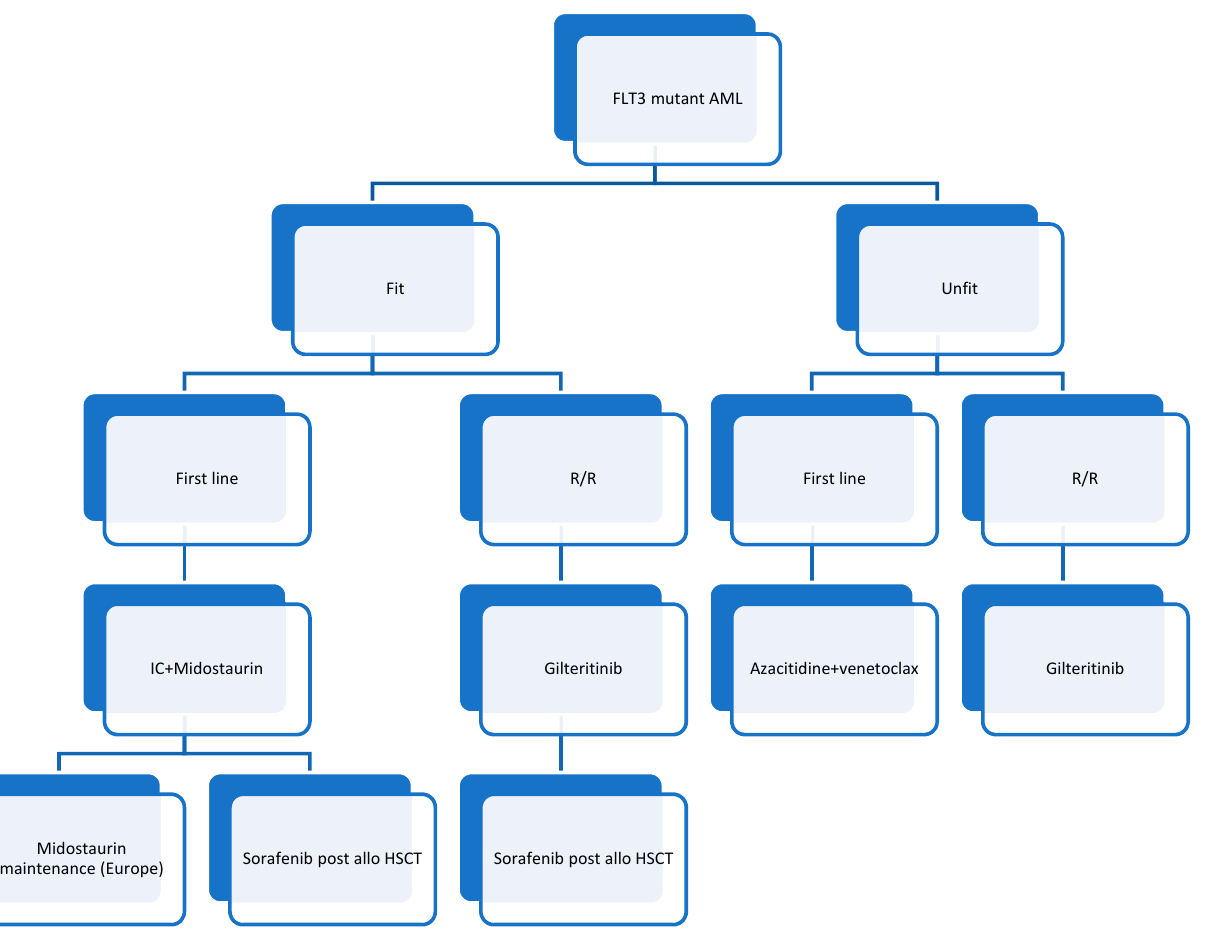
Figure 1. Recommendations for the treatment of fit and unfit patients with FLT3-mutated AML.